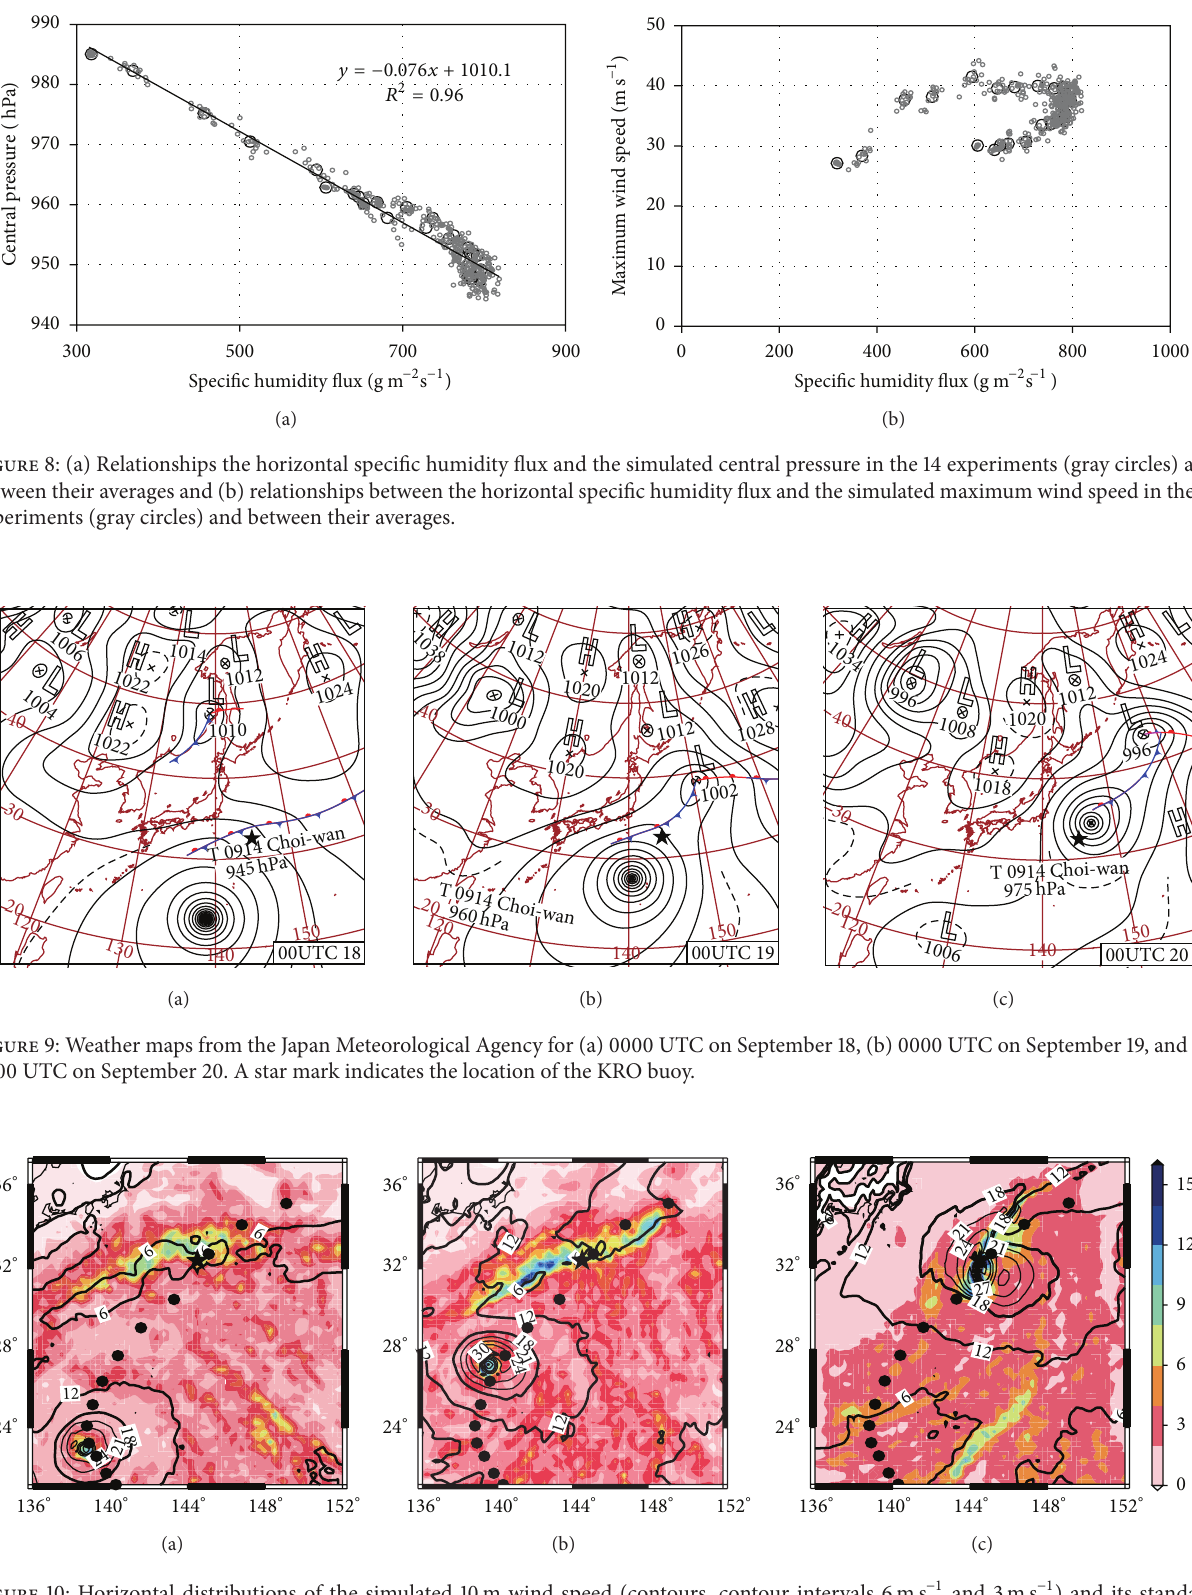
Figure 10: Horizontal distributions of the simulated 10m wind speed (contours, contour intervals 6m s −1 and 3ms −1 ) and its standard deviation (shading) at (a) 24 h, (b) 48h, and (c) 69 h. The star shows the location of the KEO moored